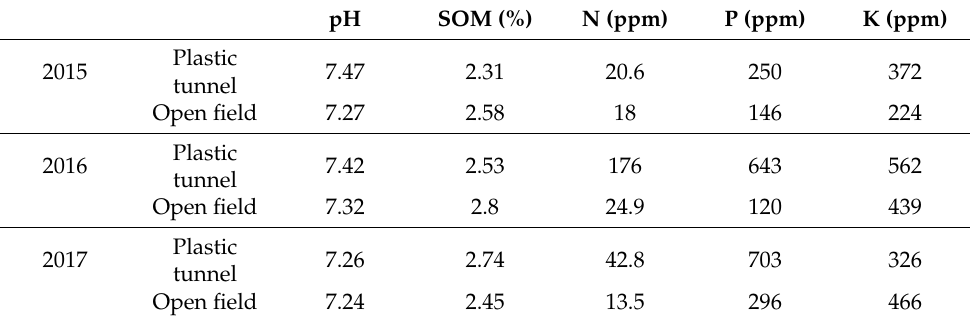
( b ) Open field, 2015–2017. Figure 2. Temperature ( ◦ C) and relative humidity (%) in 2015, 2016 and 2017 in the plastic tunnel ( a ) and open field ( b ) from the date of the planting to the end of the season. Seasons started according to the schedule of the farmers. Precipitation (mm) was measured only on the open field ( b ). Table 1. Soil parameters of the experimental locations in different years .